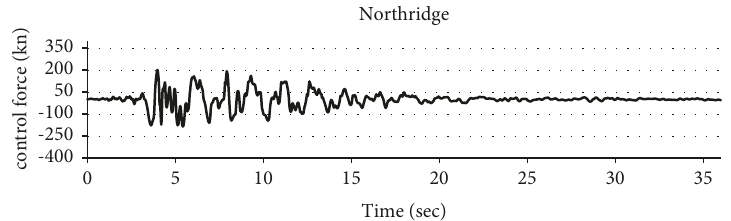
Figure 22: The control force in AP-TMD in Northridge